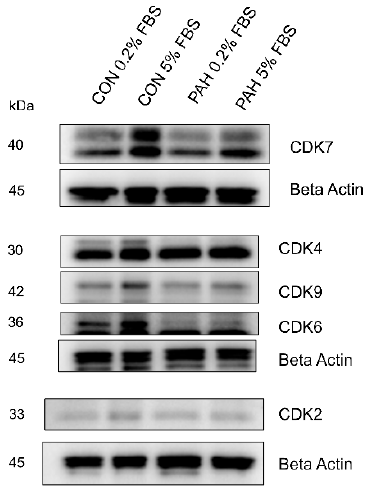
Figure 4. Expression of other CDKs in PAH HPASMC. Western blots showing expression of CDK7,